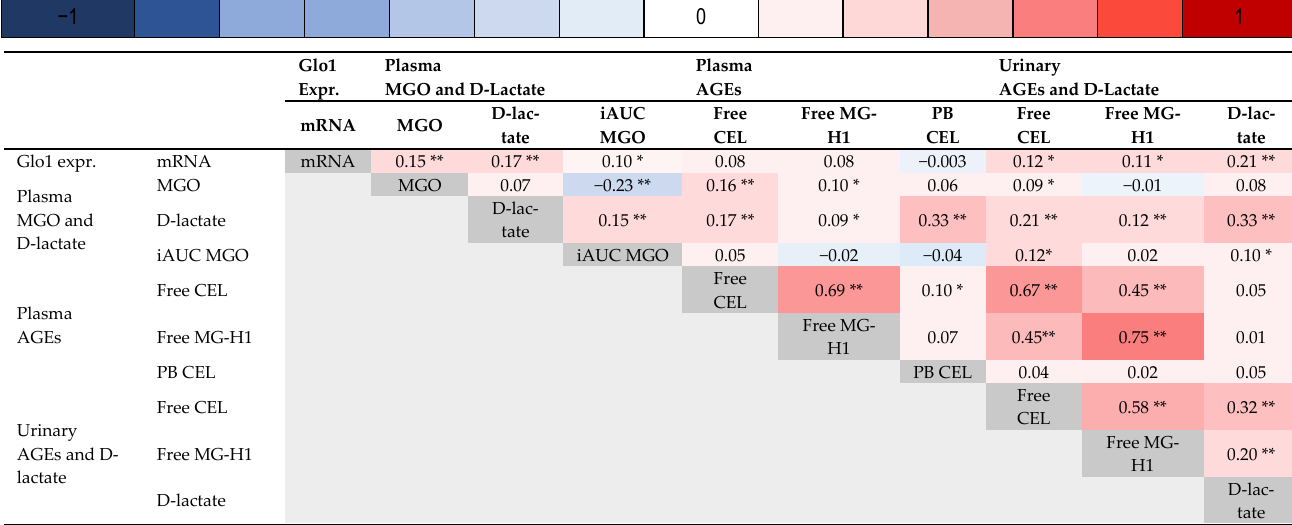
except GLO1 mRNA expression, which was measured at follow-up (2006–2009). AGE, advanced glycation endproduct;